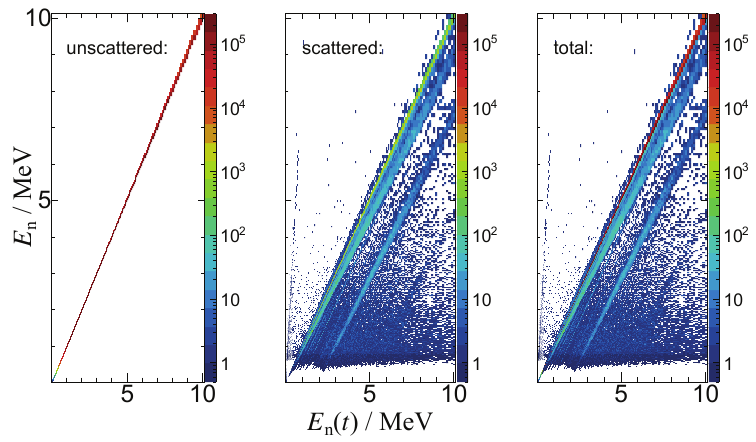
Figure 3. Simulated energy to time-of-flight-correlation of the first PuFC deposit in the neutron beam calculated using MCNP 6.1.1. Shown are from left to right: unscattered neutrons, scattered neutrons and the sum of both. Here the bin content was multiplied columnwise with the 242 Pu fission cross section to become proportional to the fission rate. The visible structures in the spectrum arise mainly from neutron elastic and inelastic scattering on target backing (mostly 28 Si) and chamber stainless steel windows (mostly 56